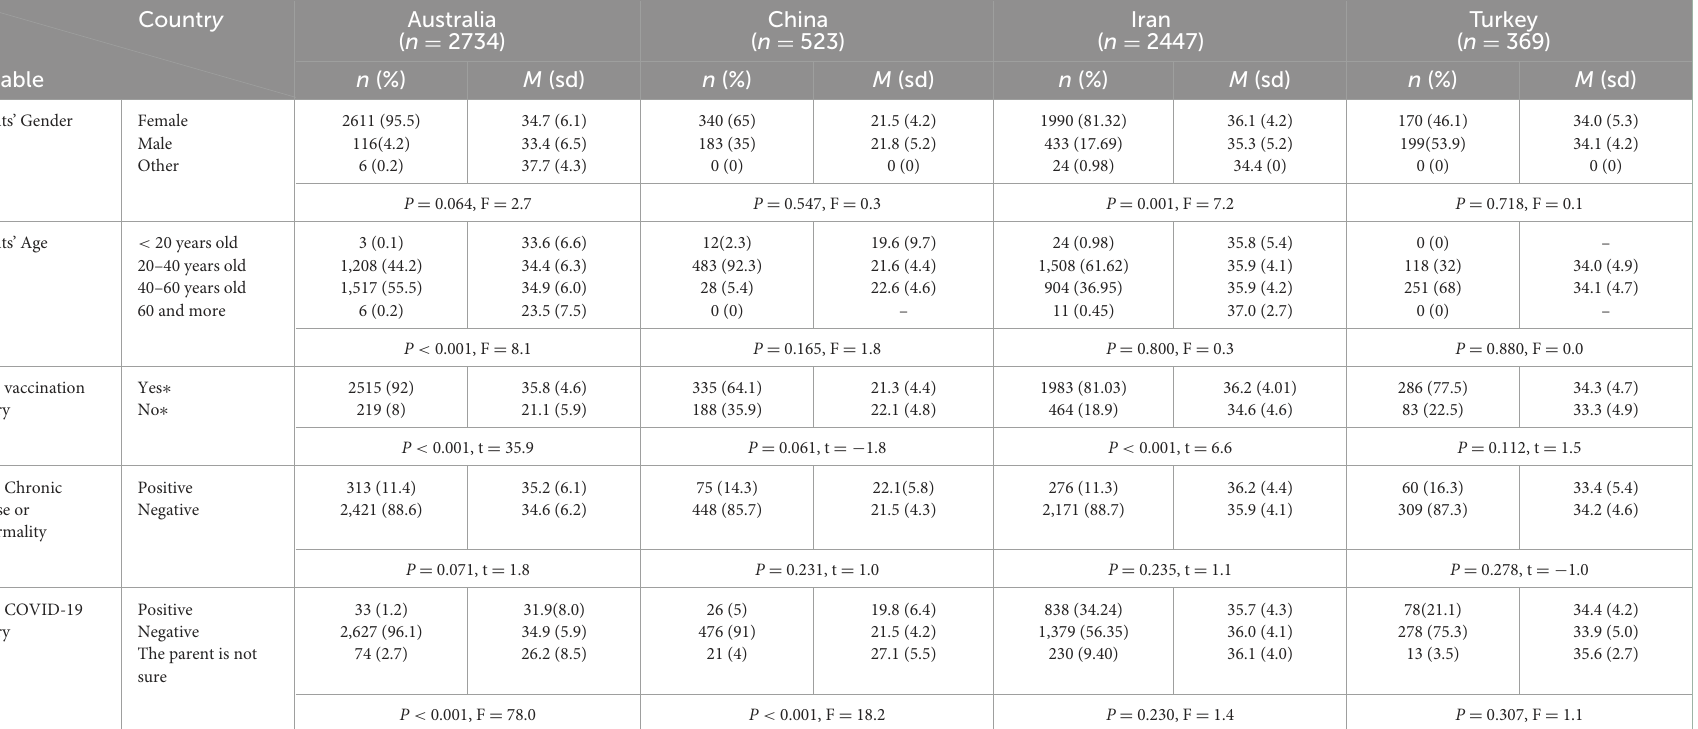
TABLE 1 Demographic characteristics of respondents and mean (SD) of COVID-19 vaccine hesitancy among parents. Countr y Australia